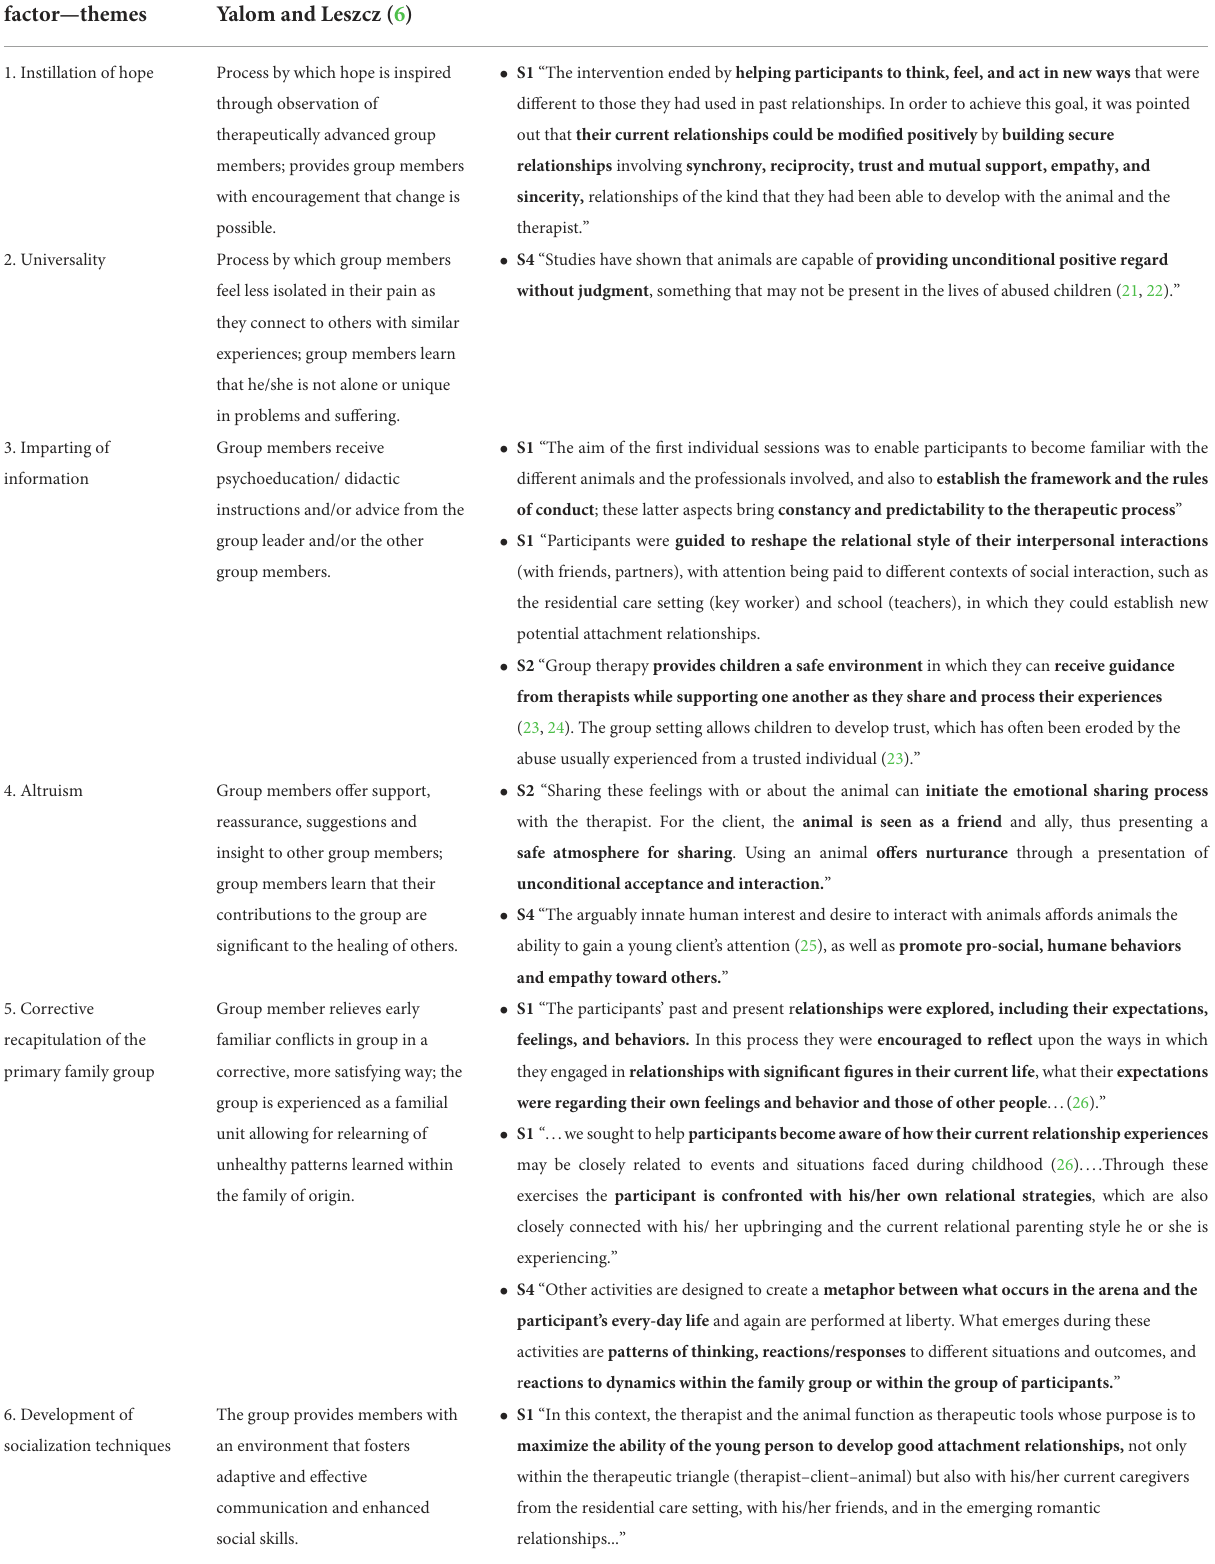
TABLE 2 Codes identified within the predefined themes (Yalom’s therapeutic factors) in the four animal-assisted group intervention studies. Group